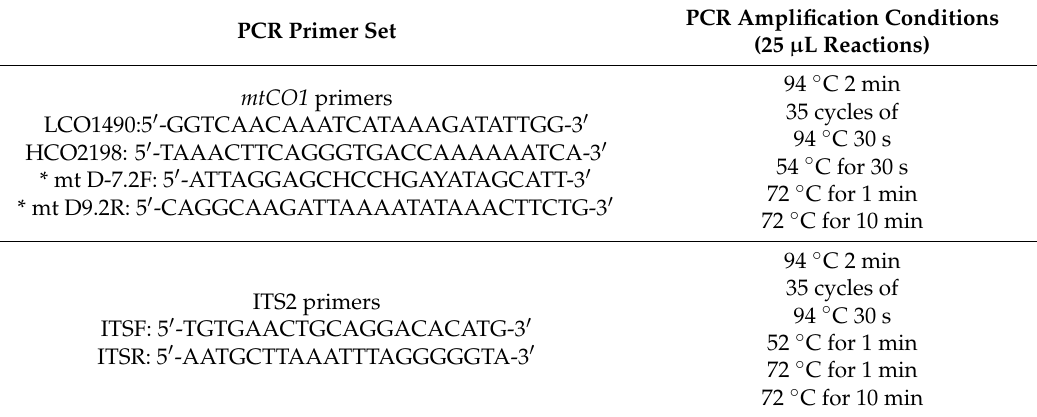
Table A2. PCR amplification conditions for two genes in Scirtothrips dorsalis , Thrips palmi and Frankliniella